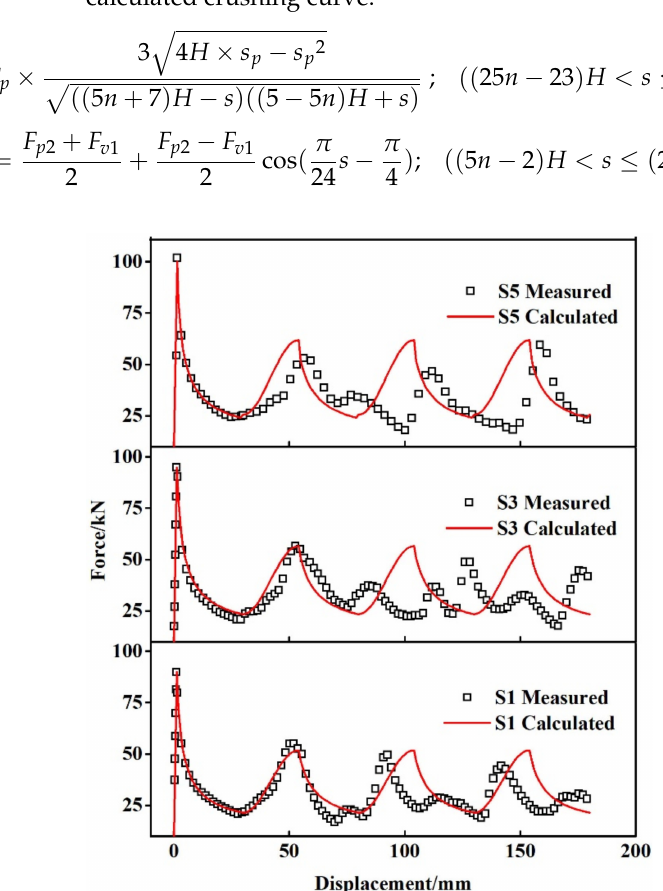
Figure 15. Calculated and measured results of crushing